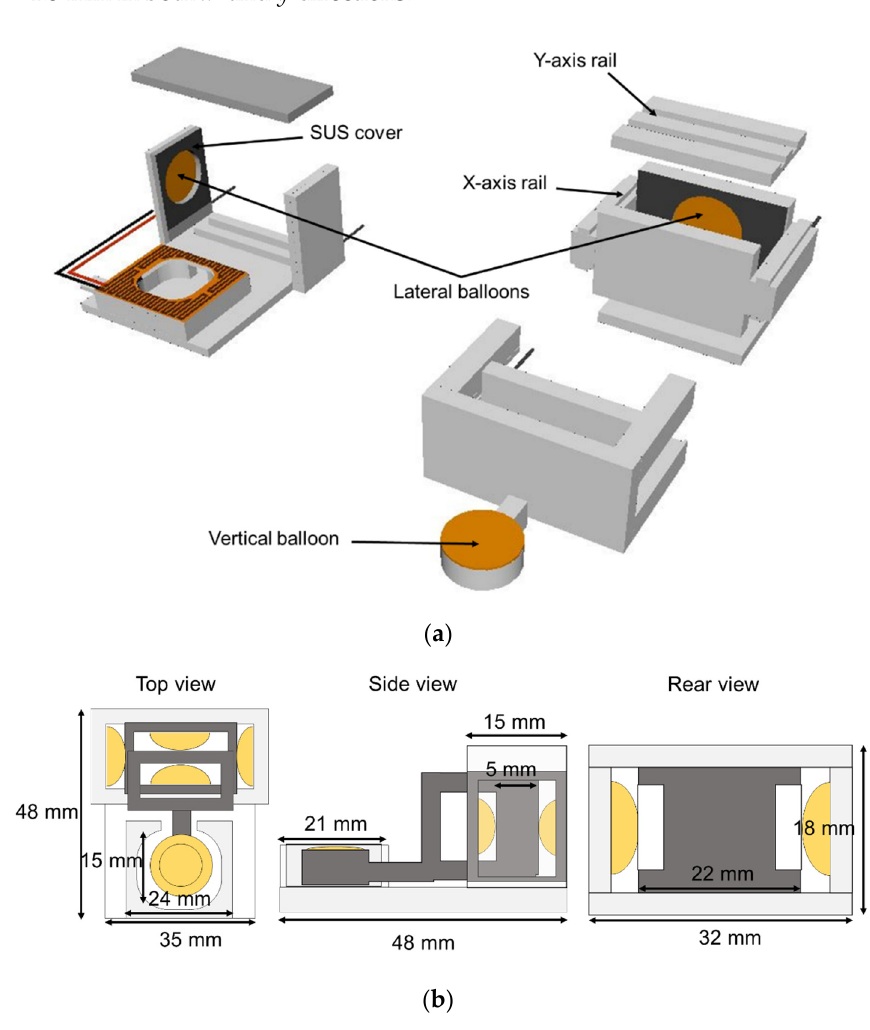
Figure 2. Disassembled view of the proposed device ( a ) and its dimension ( b ).